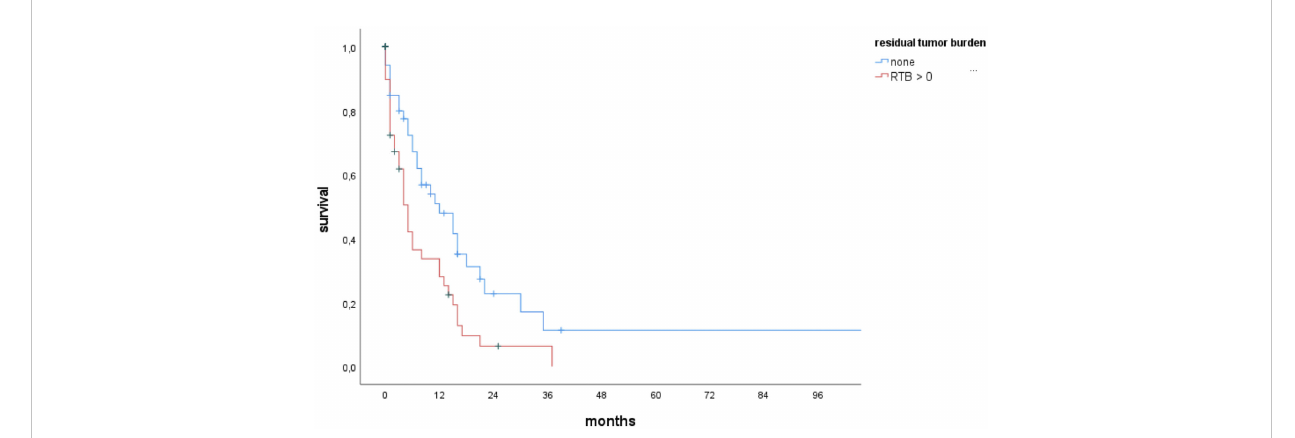
FIGURE 3 Kaplan-Meier curves for OS of elderly patients with BMs, strati fi ed according to RTB = 0, RTB >0.